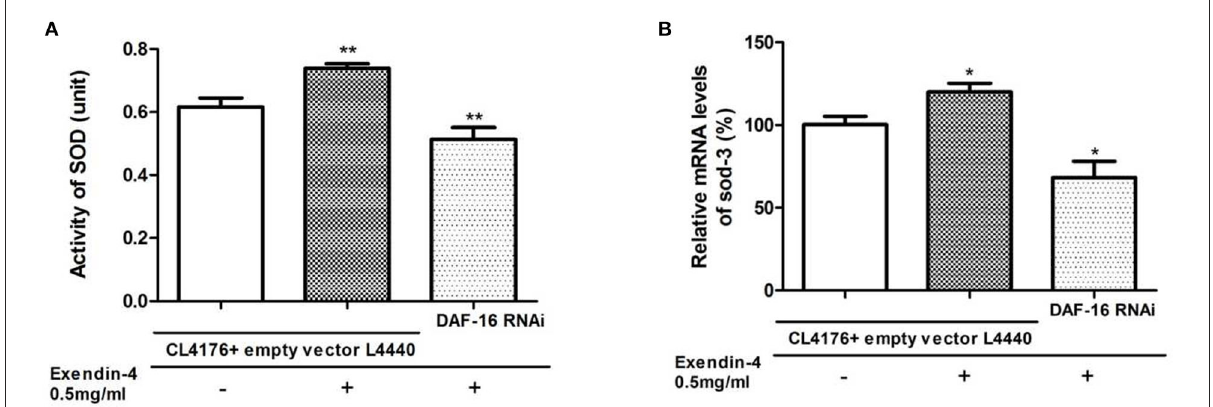
FIGURE9 Exendin-4 regulates SOD via DAF-16. CL4176 worms with empty vector L4440 as control were treated with or without 0.5 mg/ml Exendin-4. CL4176 worms were knocked down the daf-16 gene by RNAi and treated with 0.5 mg/ml Exendin-4. (A) The total SOD activity in worms was investigated using the NBT method. Compared with the control group treated with Exendin-4, the SOD activity was decreased by 30.45% after knocking down the daf-16 gene ( p < 0.01). (B) Compared with the control group treated with Exendin-4, the mRNA levels of sod-3 were decreased by 43.13% after knocking down the daf-16 gene ( p <